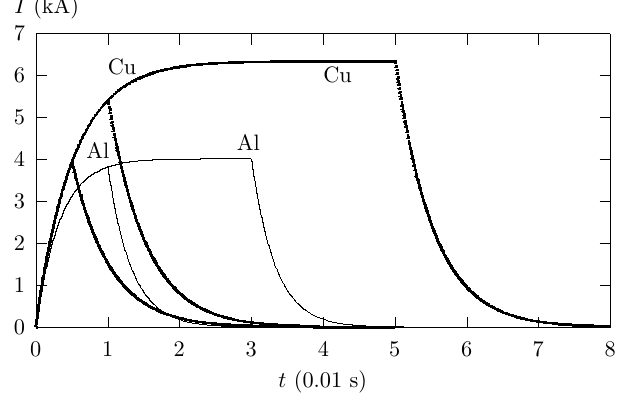
Figure 5. Example 2: The dependence of transient current on time when the source of constant current is connected at time t = 0 and is later short-circuited at time t sho = 0.005,0.01,0.05 s. The curves (solid lines) denoted by Cu correspond to copper conductors. The curves (thin lines) denoted by Al correspond to aluminium conductors at a temperature of 300 K, (cid:36) = 2.733 t sho = 0.01,0.03